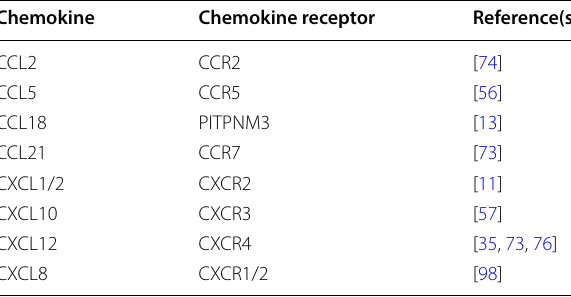
Table 3 Breast cancer metastasis-associated chemokines and their